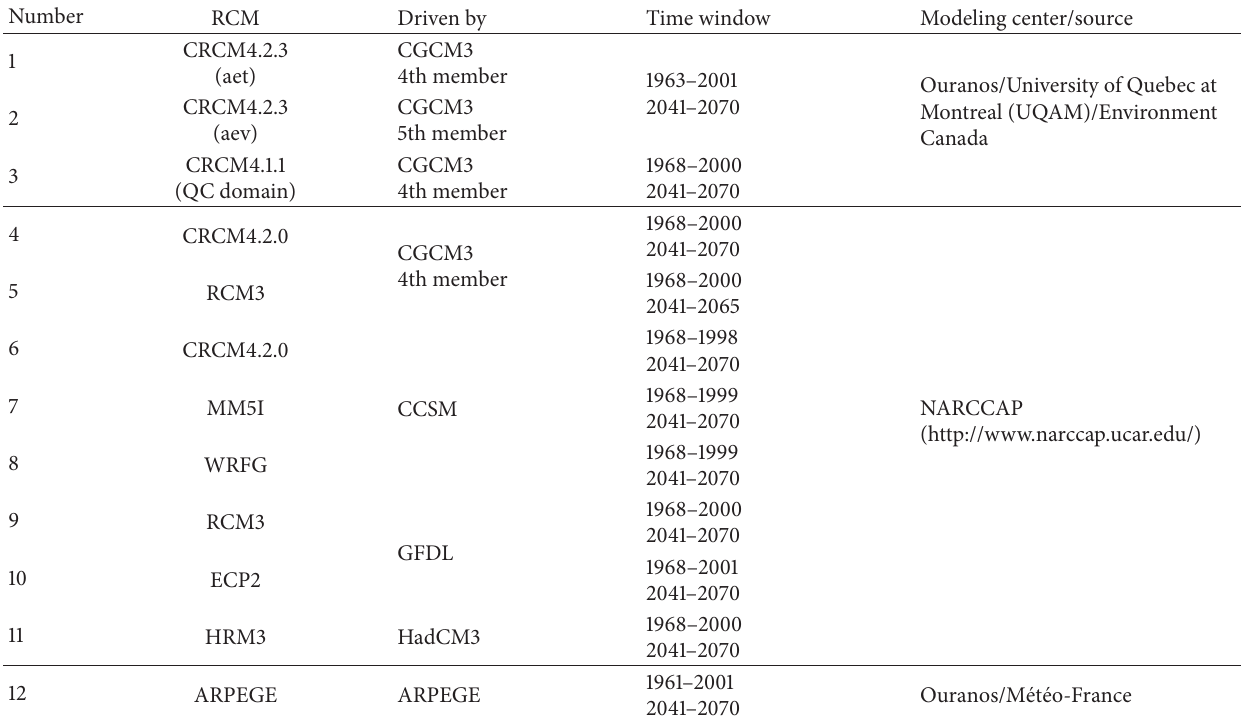
Table 1: Description of RCM/AOGCM combinations used in this